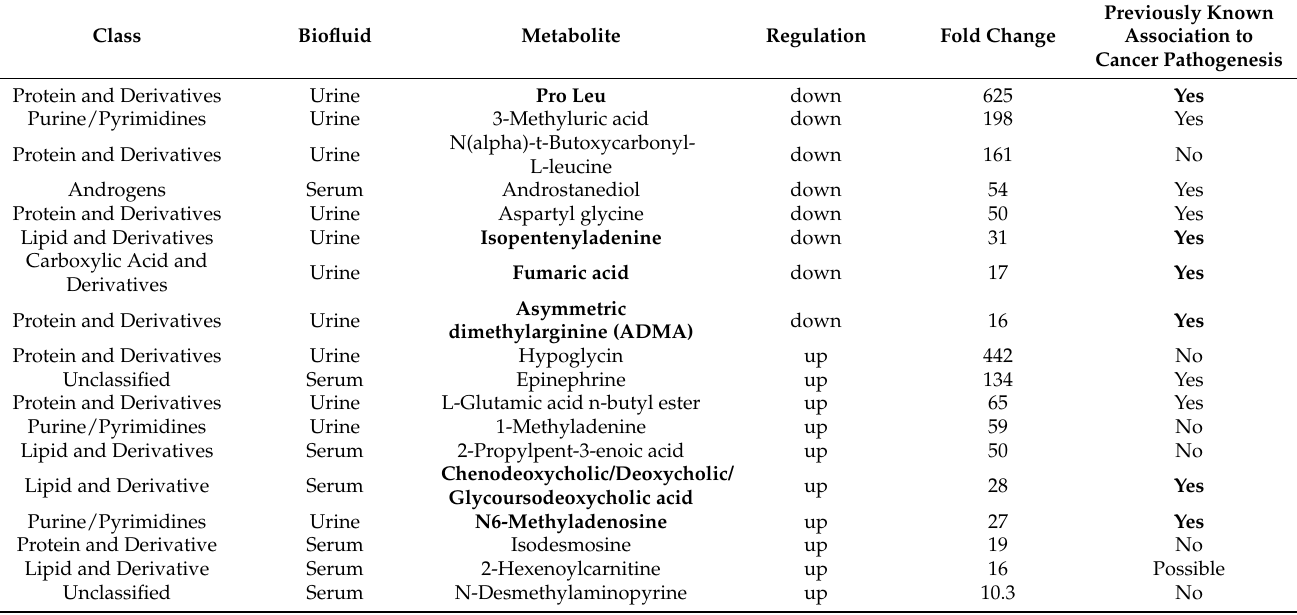
Table 5. Metabolites of significance (FC >